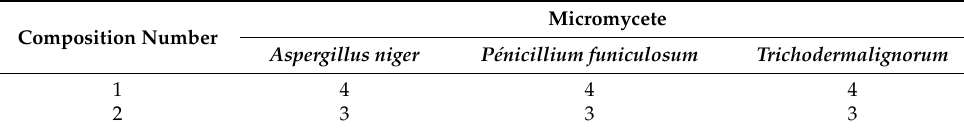
Table 5. Evaluation of the biostability of PVC composites in